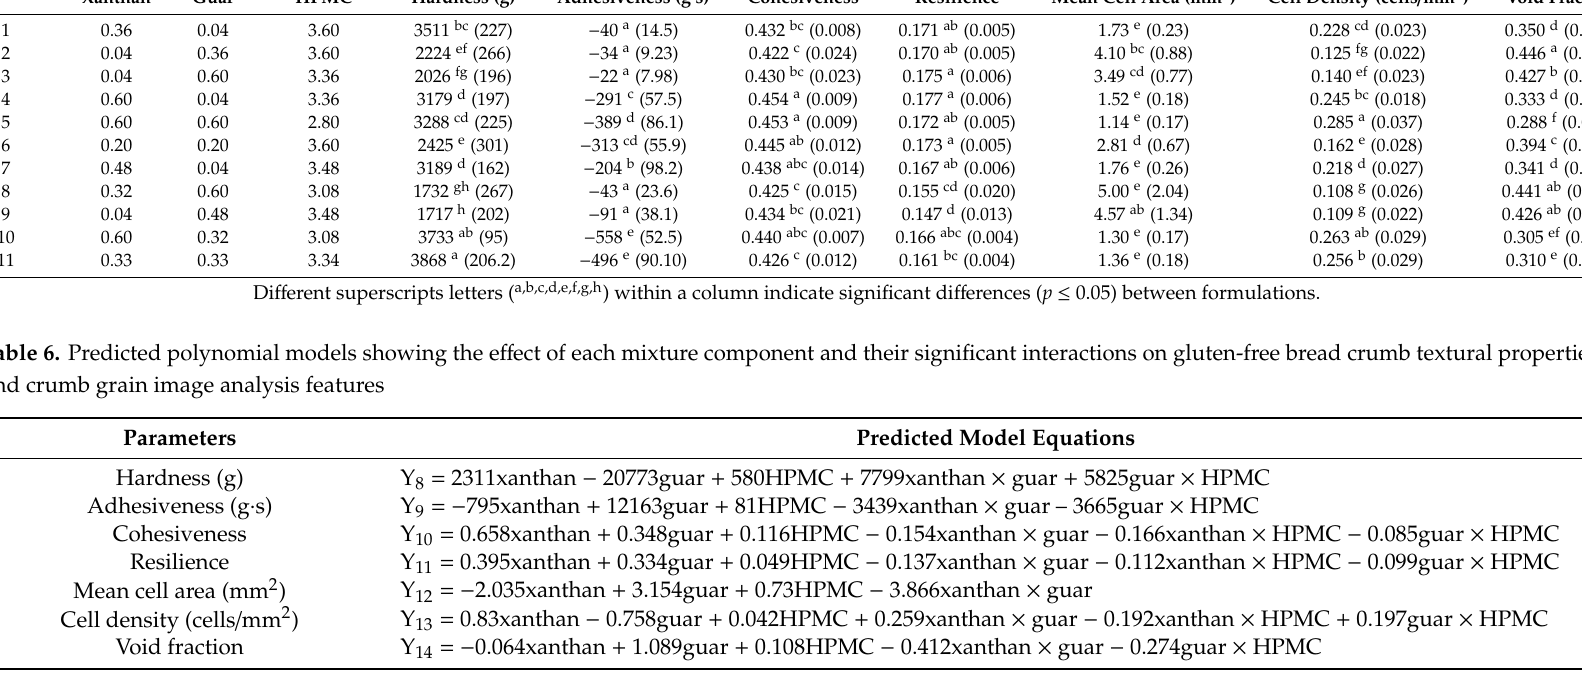
Table 5. Mean values and standard deviations (in brackets) of the gluten-free bread crumb textural properties and crumb grain image analysis features extrusion by formulation Formulation